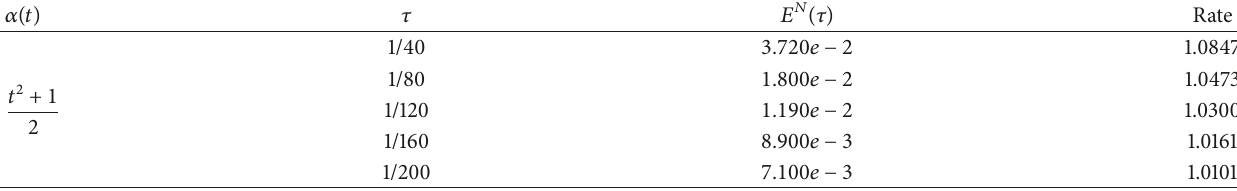
Table 3: Maximum errors and convergence rates for Example 1 at 𝑇 = 1 and 𝜎 1 = 𝜎 − 0.1 .